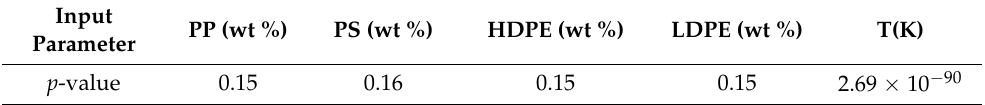
Table 9. The p -values of the input